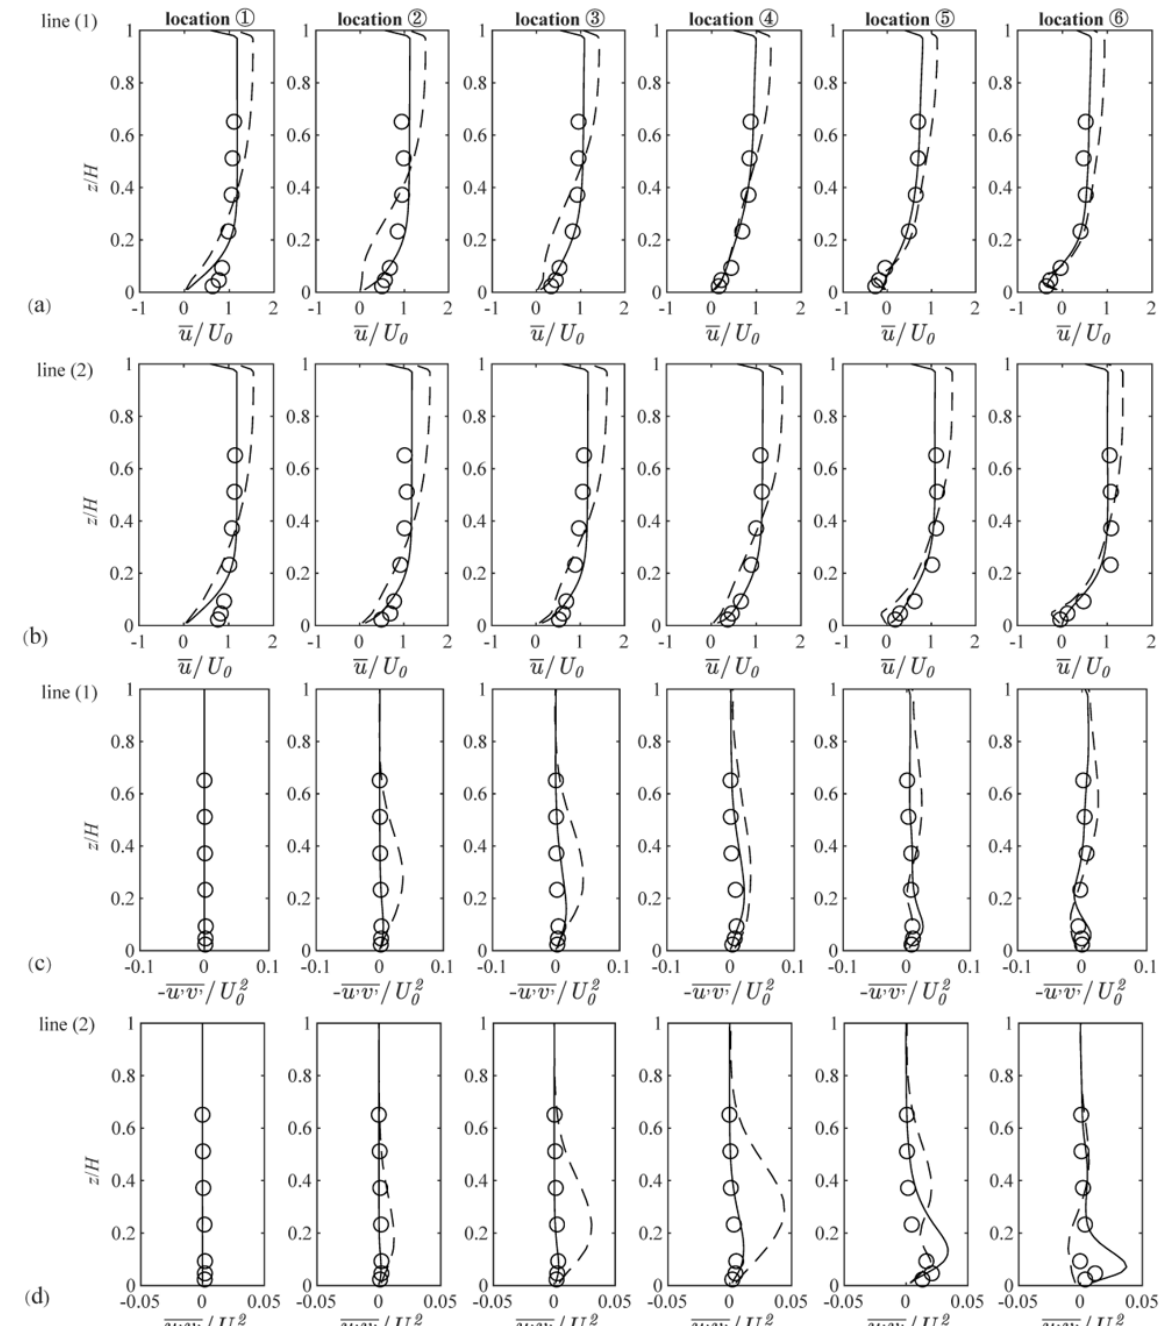
Figure 3. Validation results of the vertical profiles of the dimensionless ( a , b ) time − averaged stream- wise velocity and ( c , d ) primary shear stress at the locations of sampling lines (1) and (2) in Case 1. Circles represent the experimental values, solid lines represent the fine − mesh simulations, and dashed lines represent the coarse − mesh simulations.